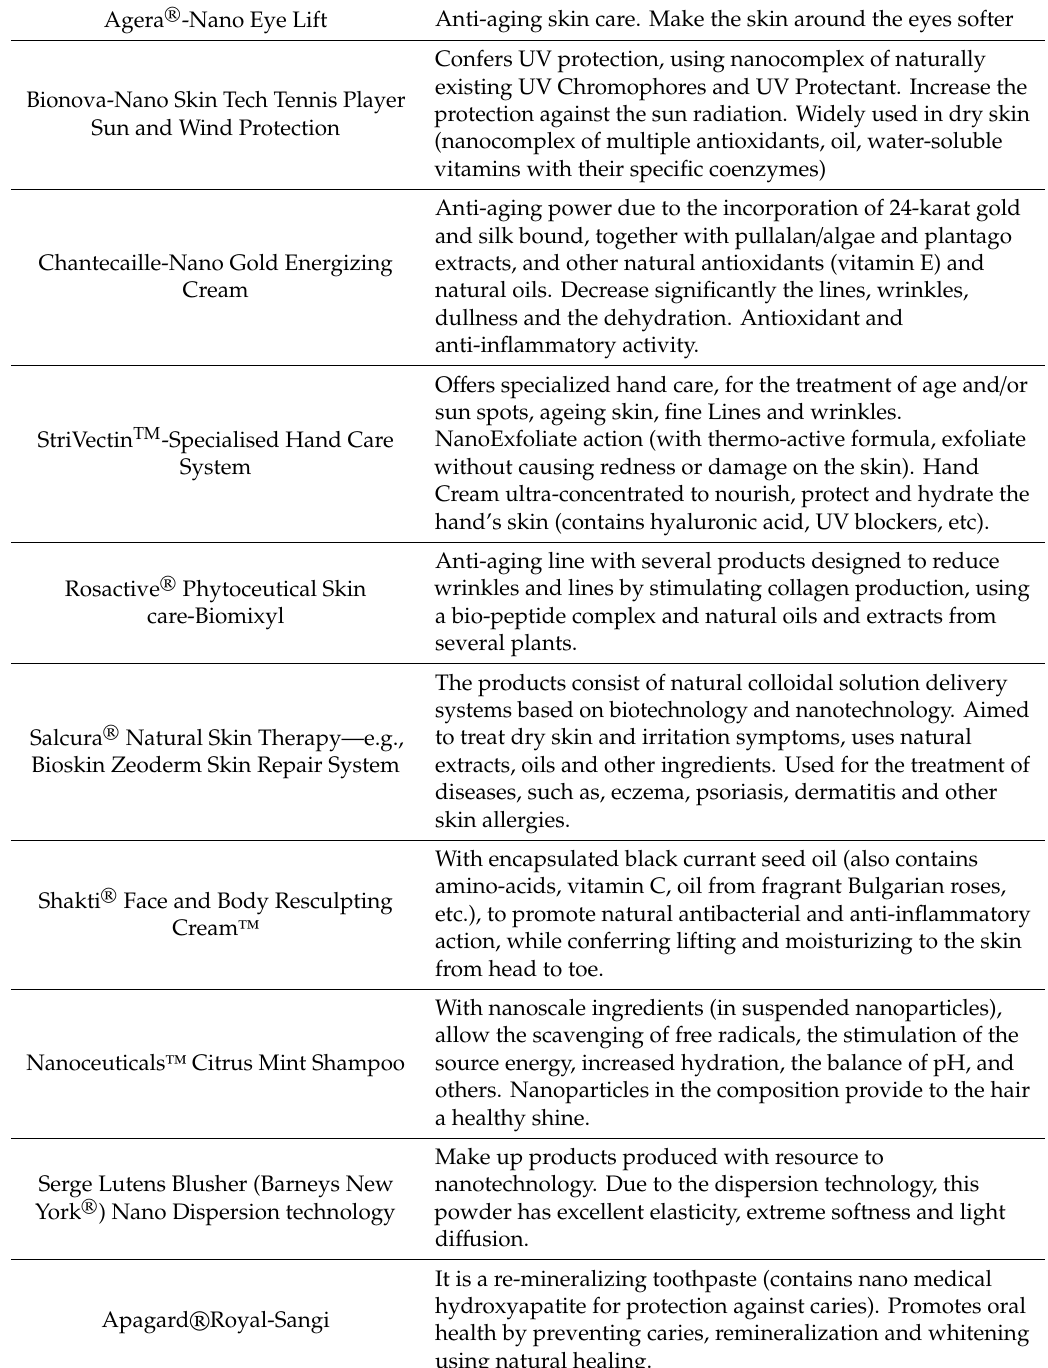
Table 1. Anti-aging products available to consumers and their respective